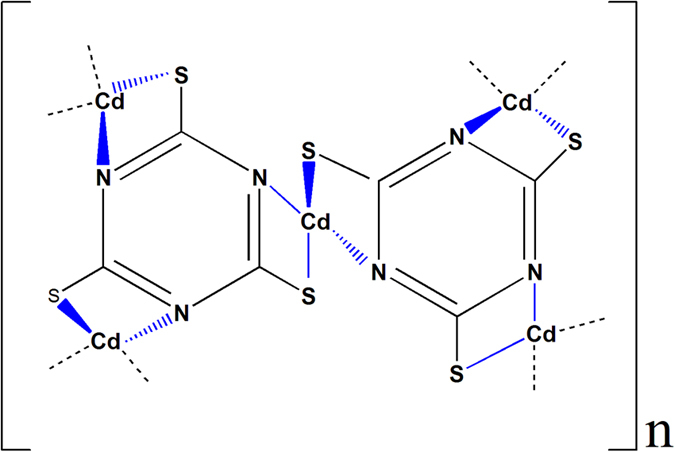
Structure of the Cd3(TMT)2 coordination polymer.